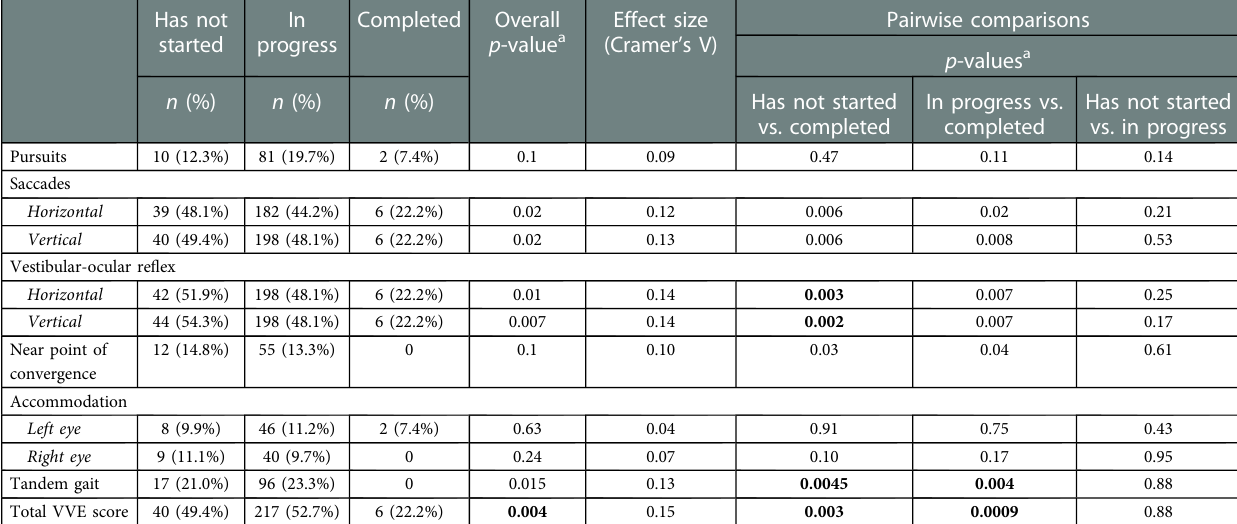
TABLE 4 Percentage of patients with abnormal VVE at follow-up by self-reported progress with the home visio-vestibular program and post-hoc pairwise comparisons ( α =0.005). Has